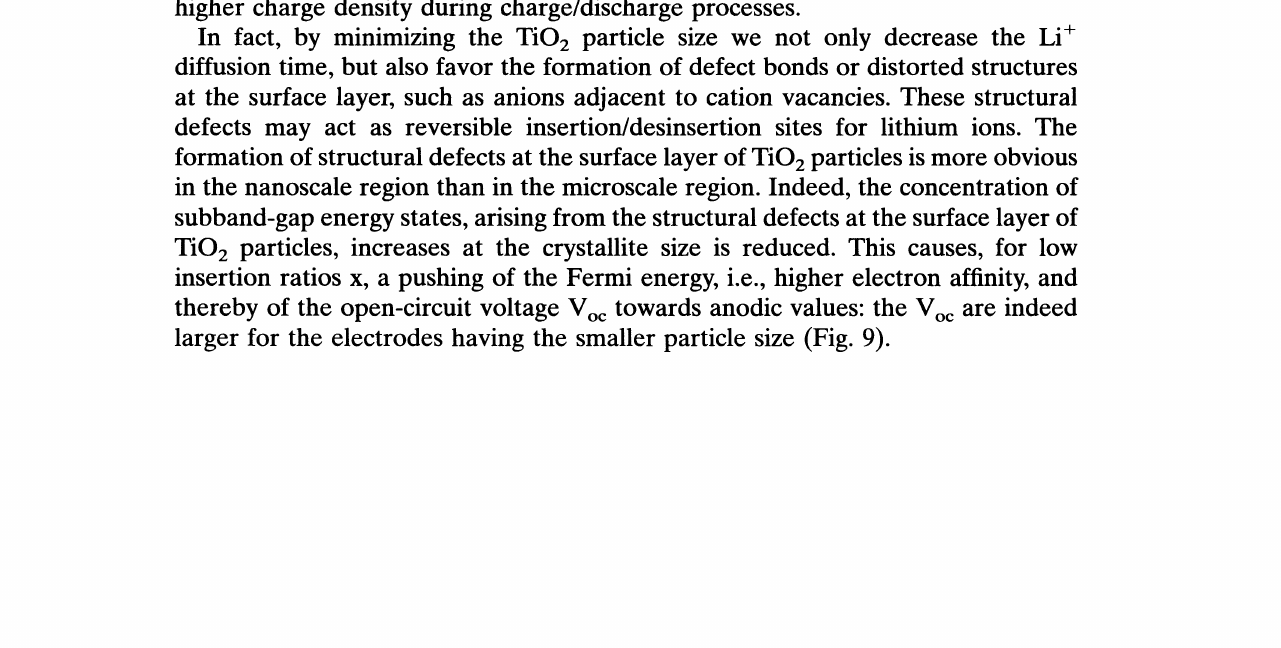
FIGURE 7 X-ray diffraction of LixTiO2 powders (a): TiO2 with lager particle size (Fluka), (b): with smaller particle size (UV100). reactions. That may be the reason for higher electrochemical kinetics in nanosized particle electrodes than in microsized particle ones: larger storage capacity and higher charge density during charge/discharge